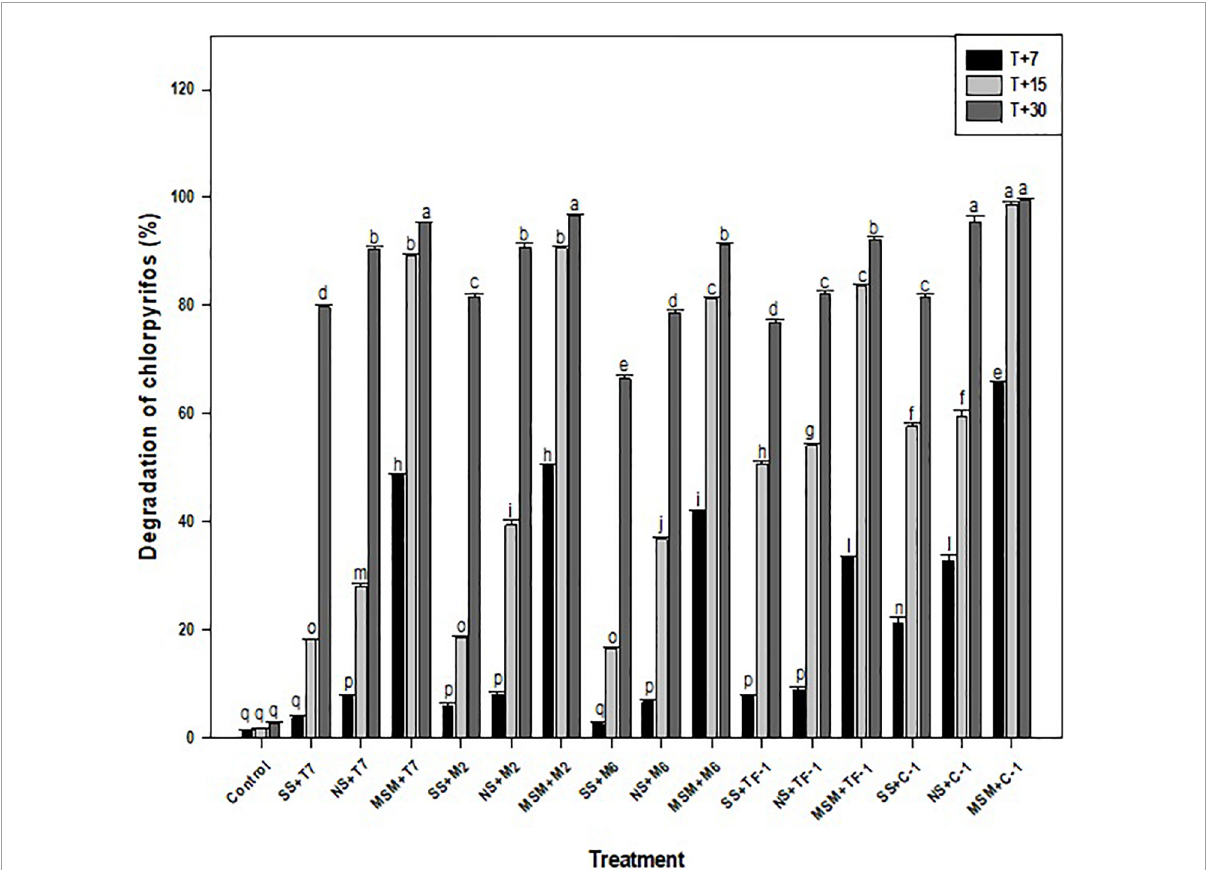
FIGURE3 Chlorpyrifos biodegradation in different media at different time intervals. Data were the average of five replicates ( n = 5). Bars represent standard error. Significant differences based on the analysis variance (ANOVA) are shown by different letters above the error bars, followed by the post-hoc DMRT test ( p ≤ 0.05) using the software